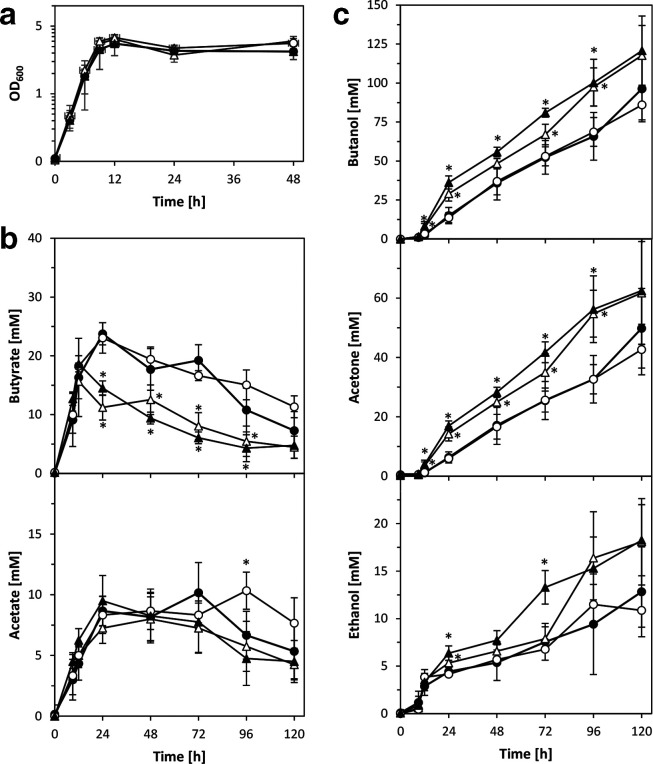
Fermentation profiles of qspB-overexpressing
C. acetobutylicum
 wild-type and qspB mutants. Growth (a) and production of acids (b) and solvents (c) were compared for the ATCC 824 parent strain (closed symbols) and qspB mutant (open symbols) containing either the empty pMTL85143 vector (circles) or the overexpression plasmid pMTL85143-qspB (triangles). Data represent the mean of four independent CBMS cultures with error bars indicating the standard deviation. Significant differences (P≤0.05) compared to the vector controls are indicated by an asterisk next to the relevant data point.